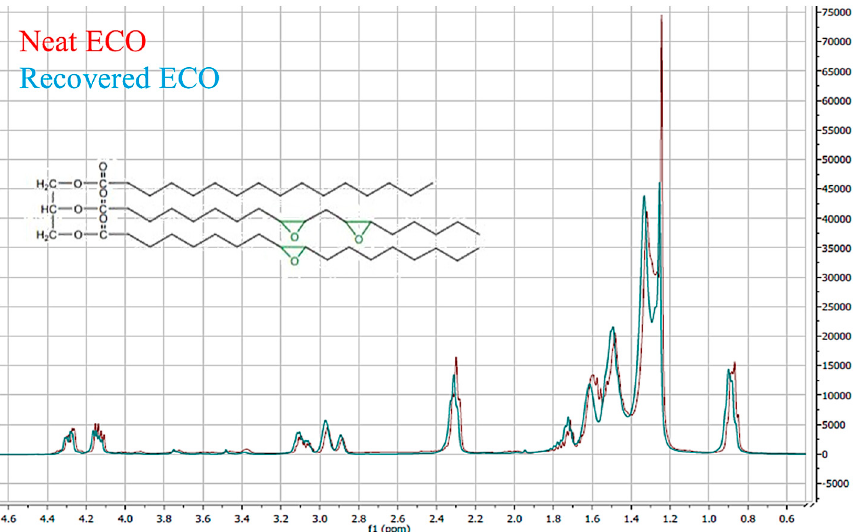
Figure 2. 1 H-NMR overlapping spectra of: neat ECO (red) and recovered oily fraction (azure curve).